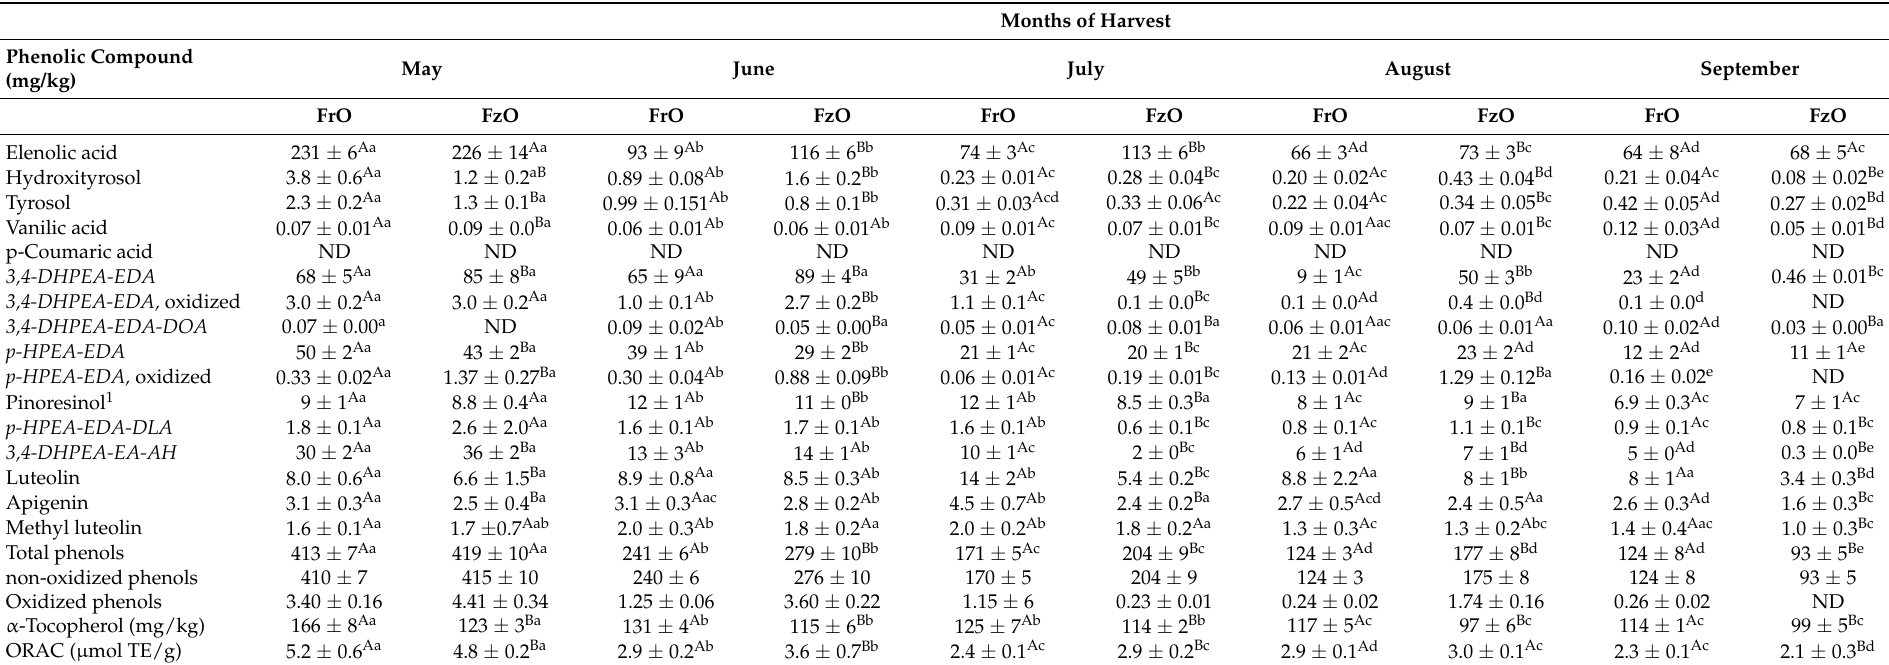
Values are mean ± SD ( n = 3). Different capital letters in the same row for each month indicate significant differences between VOO from fresh and frozen olives ( p < 0.05; LSD Fisher). Different lower-case letters in the same row indicate significant differences between oils of different ripening stages ( p < 0.05; LSD Fisher). Oils from fresh and frozen olives are compared separately. Abbreviations: FrO, Oil from fresh olives. FzO, oil from frozen olives. 1 : Mixed with 1-acetoxy-pinoresinol. 3,4-DHPEA-EDA, dialdehydic form of decarboxymethyl oleuropein aglycon. 3,4-DHPEA-EDA-DOA, dialdehydic form of oleouropein aglycon. p-HPEA-EDA, dialdehydic form of decarboxymethyl ligstroside aglycon.